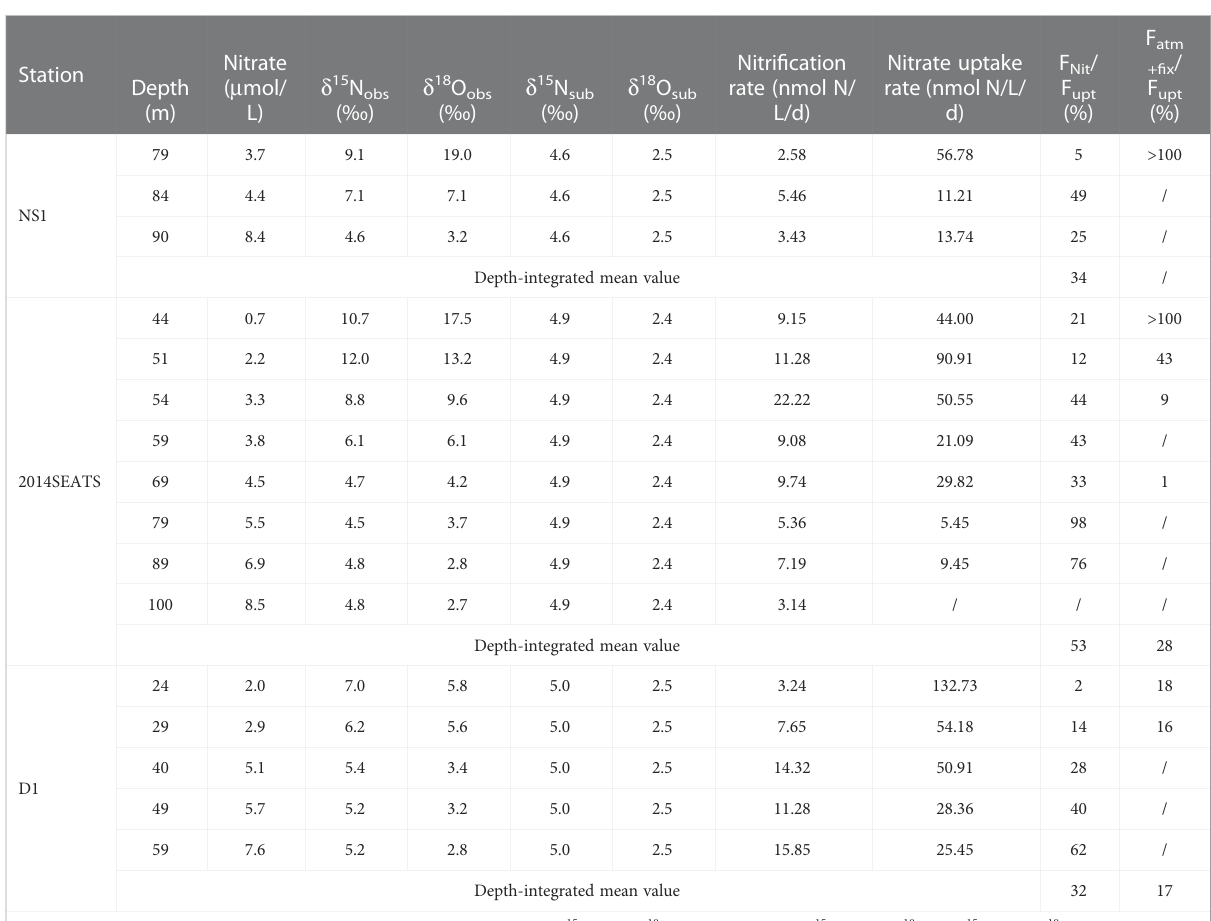
TABLE 2 Summary of nitri fi cation rates, NO 3 – uptake rates, the contributions of nitri fi cation to NO 3 – uptake (F nit /F upt ), and the contributions of external N inputs to